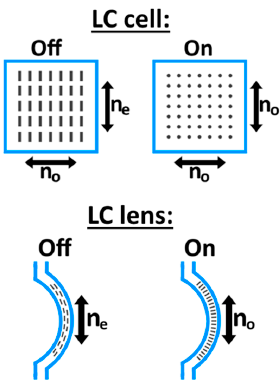
Figure 2. Illustration of how the refractive index of a device and schematic lens changes for specific orientations of the liquid crystal. The ground-state orientation can be controlled by surface treatment and modified by application of a voltage above a threshold.